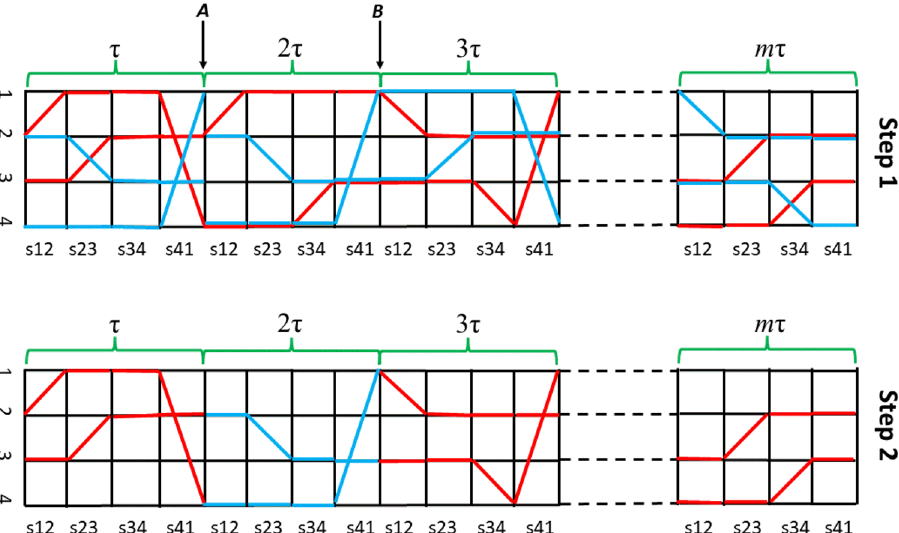
Figure 1. The graphic representation of the two-step sampling technique for a ring of four sites half-filled Hubbard model. The horizontal and vertical direction refers the time slices and lattice sites, respectively. “sij” is the shorthand of e − τ h ij , indicating the scatting operator between two wavefunctions (vertical lines). The diagonal operator e − τ Un i ↑ n i ↓ is omitted. In upper panel (step 1), the red line denotes a closed world line ( ω o ), while the blue line denotes an open world line ( ω ′ ). The arrow A and B mark intersections between ω o and ω ′ . In lower panel (step 2), a closed world line ( ω n ) is constructed by replacing the segment between arrows A and B in ω o with that in ω ′